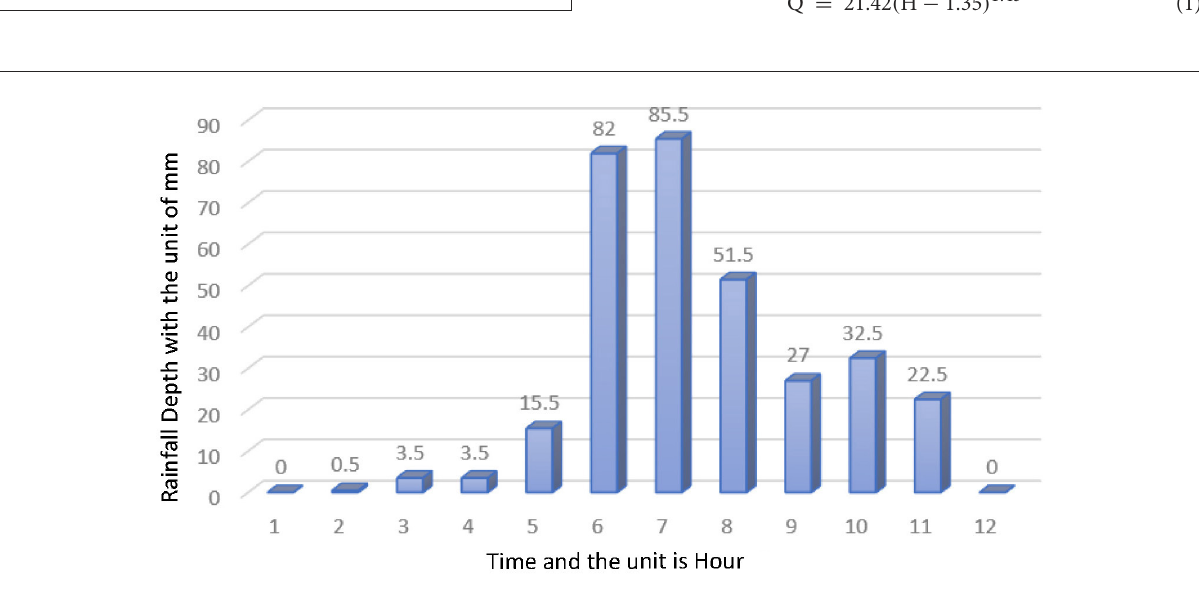
FIGURE2 Flow chart for research methodology.